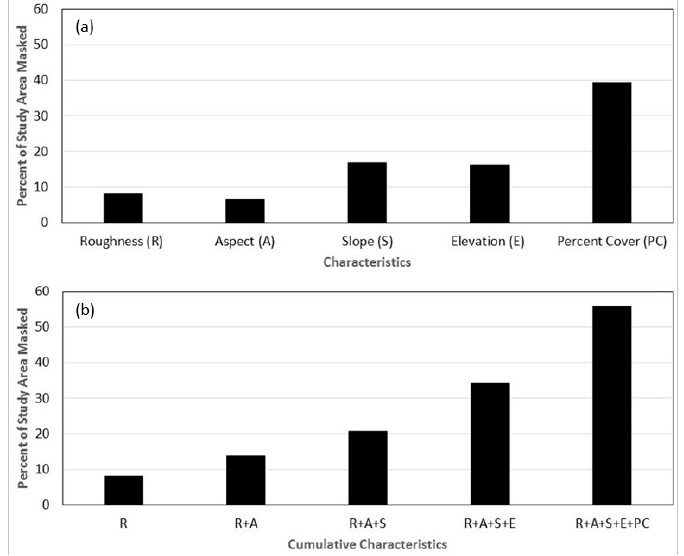
Figure 9. Bar charts showing ( a ) percent of study area masked as favorable locations for burrows, as a function of terrain and vegetation characteristics; and ( b ) the cumulative effect of the characteristics on the percent of study area masked.